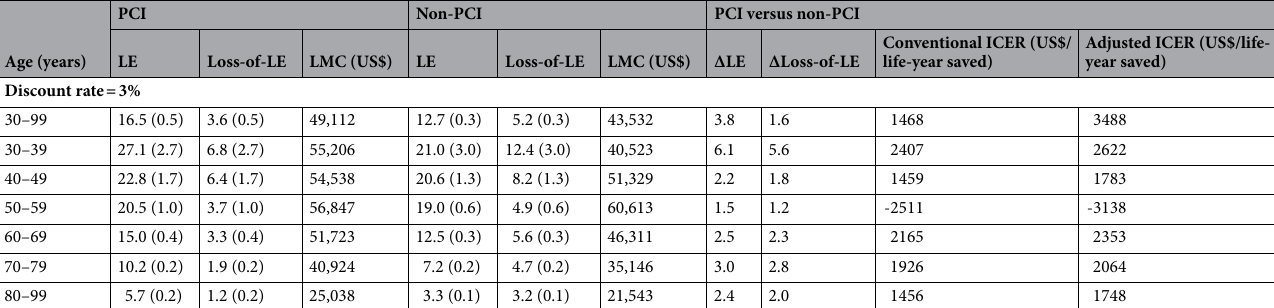
Table 2. Life expectancy (LE), loss of life expectancy (Loss-of-LE), life-year saved, lifetime medical cost (LMC, adjusted to year 2015 with a discount rate of 3%) and incremental cost-effectiveness ratio (ICER) of patients with acute myocardial infarction stratified by receiving percutaneous coronary intervention (PCI). ∆ LE was derived from (LE in PCI–LE in non-PCI). ∆ Loss-of-LE was derived from (Loss-of-LE in non-PCI– Loss-of-LE in